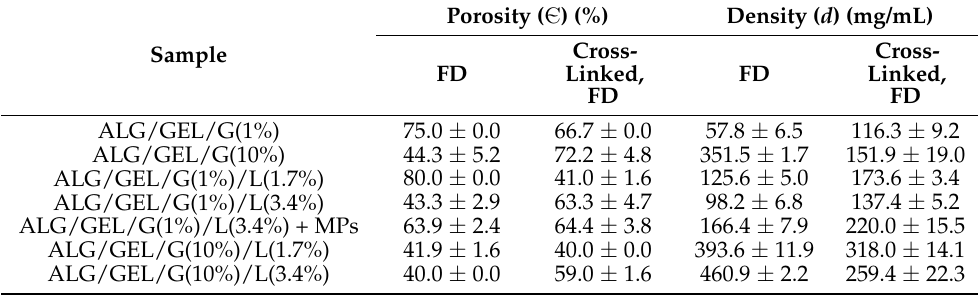
Table 2. Porosity ( Є ) and density ( d ) of freeze-dried (FD) materials based on sodium alginate and gelatin with different amounts of glycerol and lipids, as well as samples with incorporated PLA